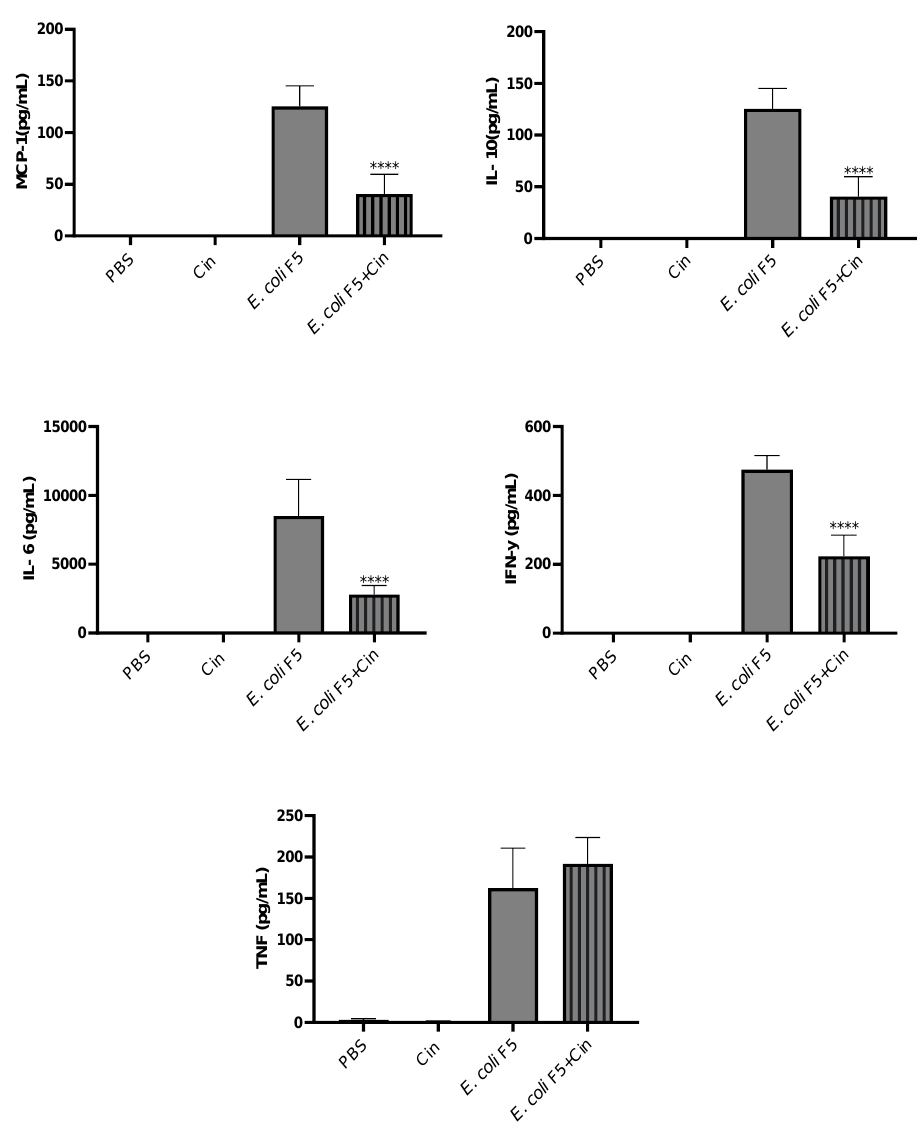
Figure 8. Detection of cytokines in the sera of animals infected with E. coli F5 and cinnamaldehyde treatment. Ten hours after peritoneal inoculation of E. coli F5, animal sera were used for cytokines dosage by flow cytometry. The results represent the mean ± S.D. of 6 animals/group. **** p < 0.0001 as compared with the E. coli F5 group.